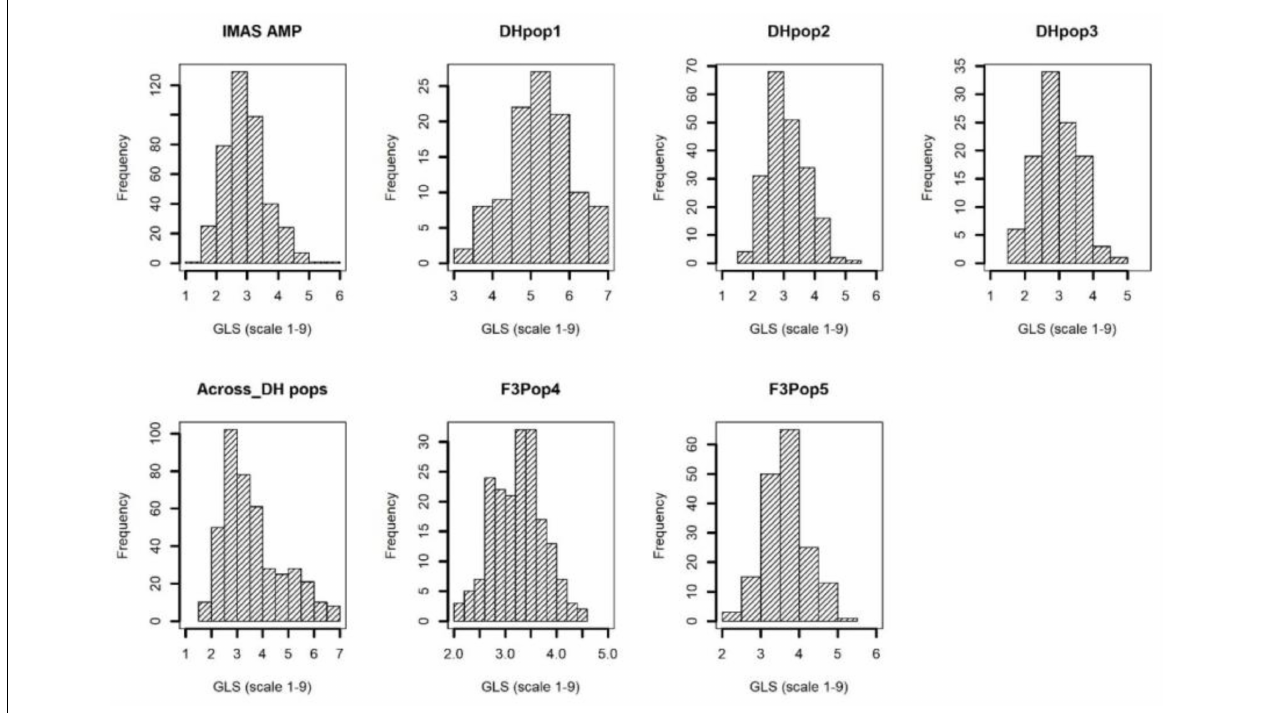
FIGURE 1 | Phenotypic distribution of GLS disease severity in IMAS association mapping panel, three DH populations, across DH populations, and two F 3 populations evaluated in two to four environments. TABLE 1 | Means and components of variance for gray leaf spot disease severity for maize inbred lines from IMAS association panel, three DH and two F 3 populations, as well as across DH populations evaluated in two to four environments.